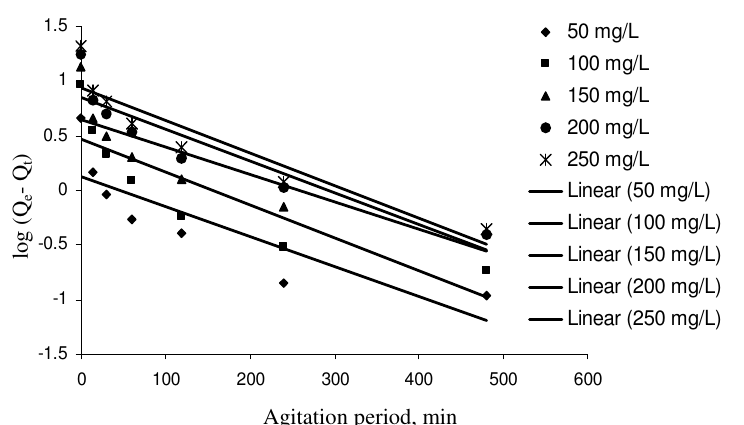
Figure 4. Pseudo-first order kinetics plot at different solute concentrations and for pH=8.